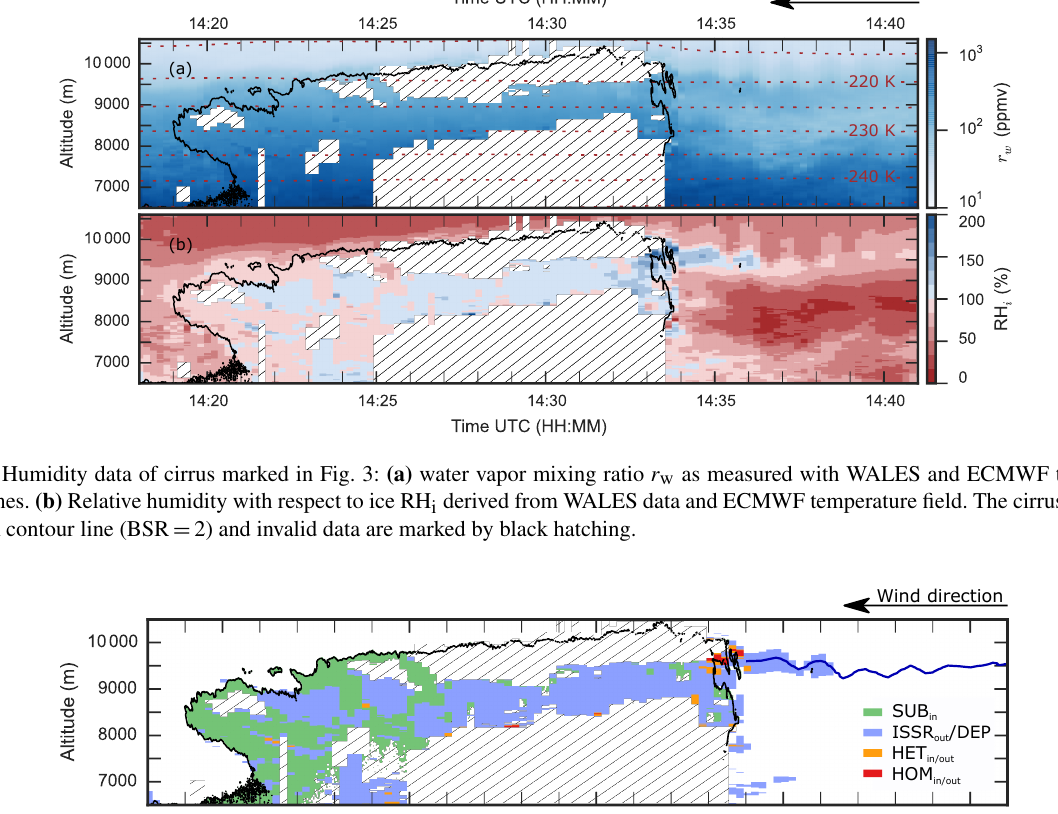
tinguished by the black contour line for a BSR value of